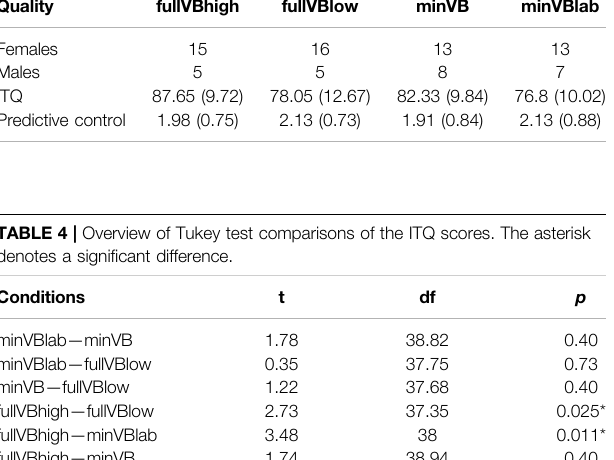
TABLE 3 | Overview of the conditions. Values are either M (SD) or n . Quality